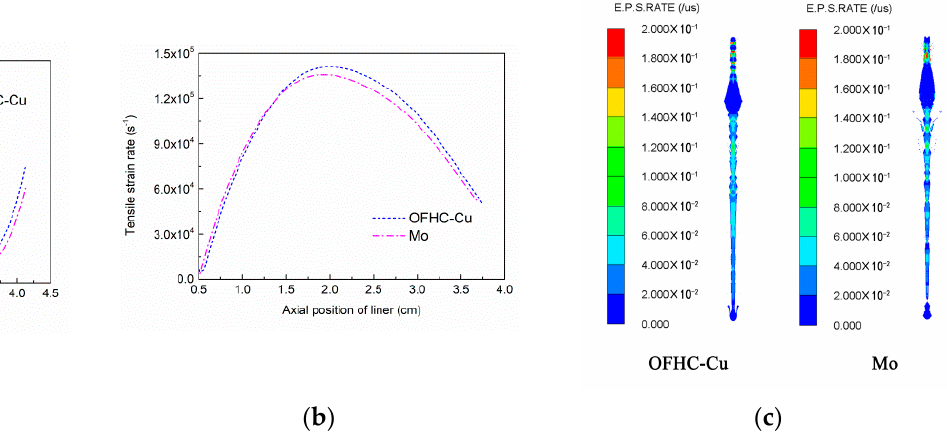
Figure 9. Strain-rate distribution of the OFHC-Cu and Mo jets. ( a ) Collapse strain rates; ( b ) Tensile strain rates (at 40 µs); ( c ) Numerical simulations (at 40 µs). strain rates (at 40 µ s); ( c ) Numerical simulations (at 40 µ Table 3. Distribution of the deformation strain rate of each jet at 40 µs and data comparison.